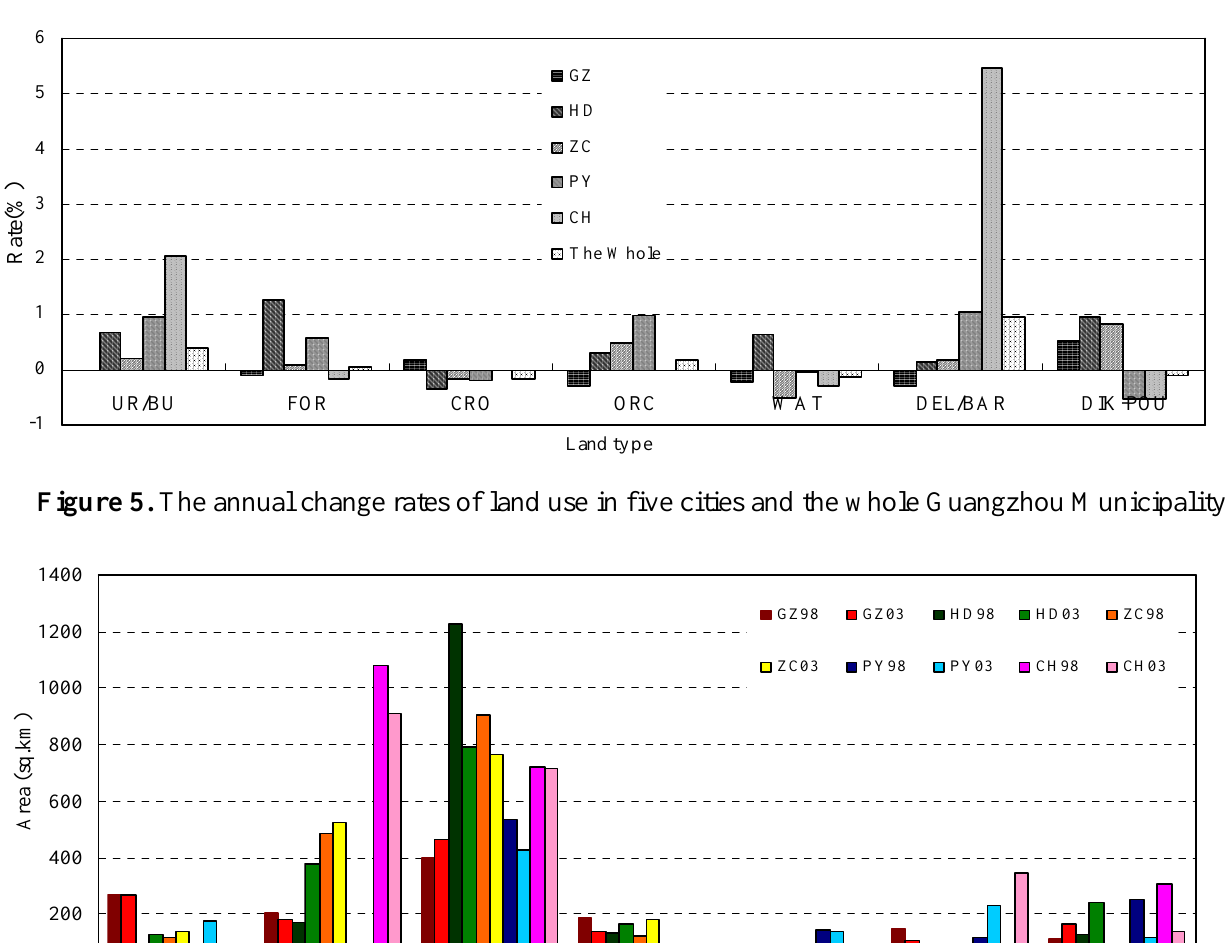
Figure 4. The land use change areas of five counties of Guangzhou Municipality from 1998 to 2003.